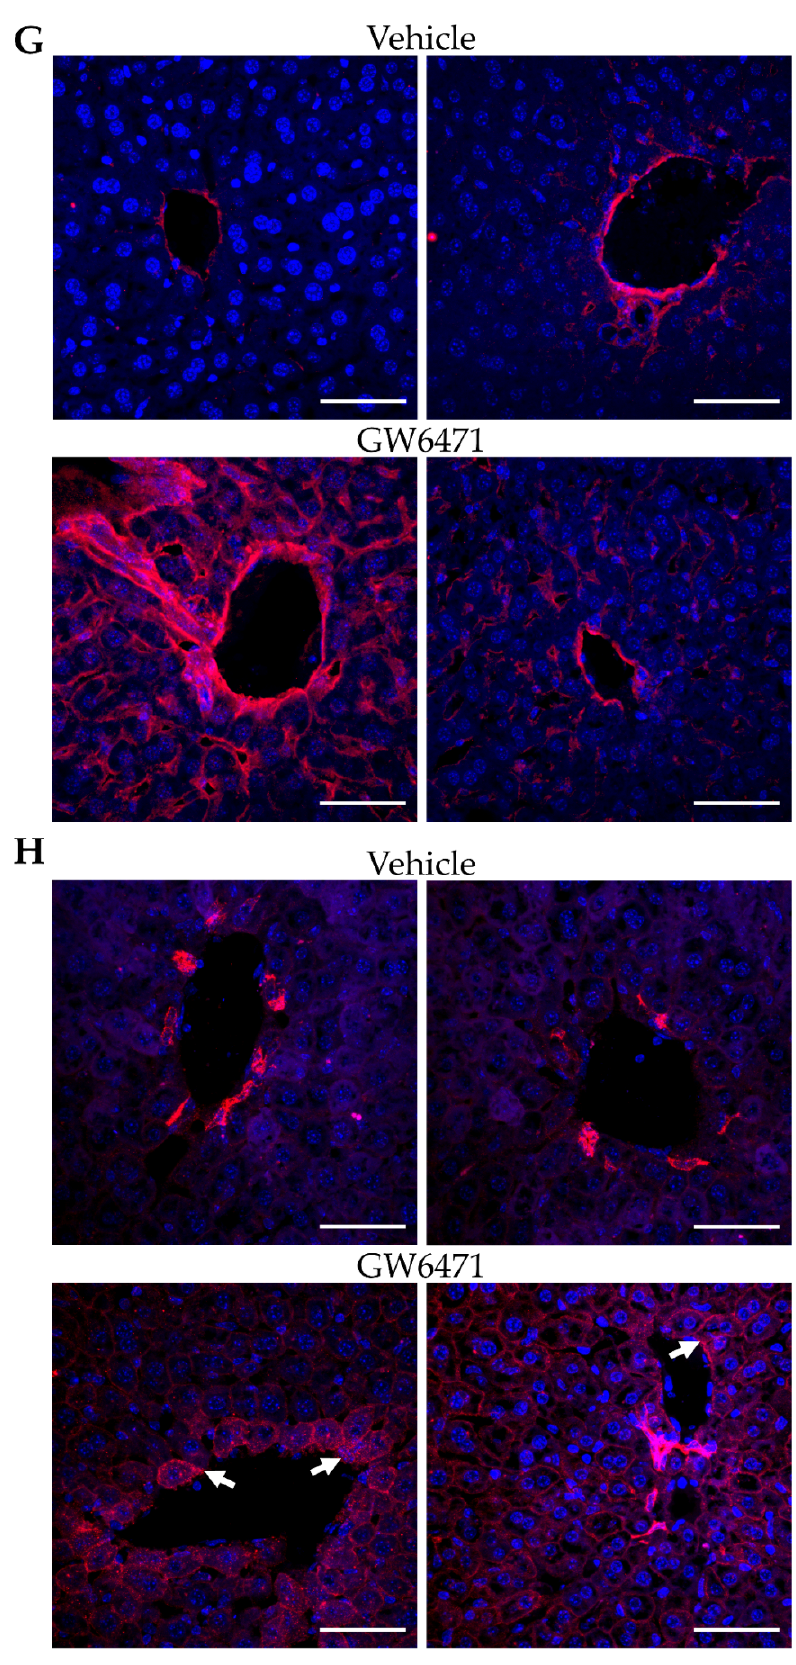
Figure 5. Gene expression and histological staining in mouse liver treated with GW6471—fold change in gene expression of ( A ) Krt18, ( B ) Krt7, ( C ) Col1a1, ( D ) Dync1h1 and ( E ) Sdc1 in liver tissue of